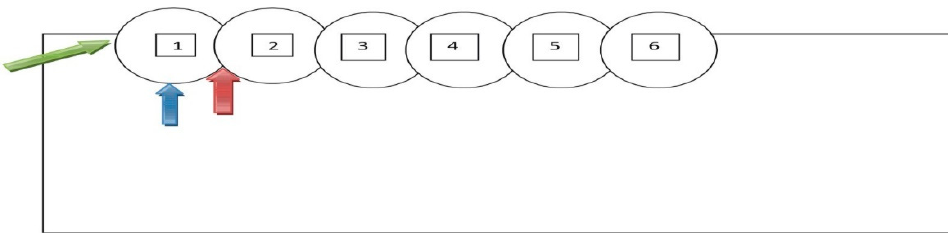
Figure 10. Native material: ferritic–pearlitic in a banded system after rolling.